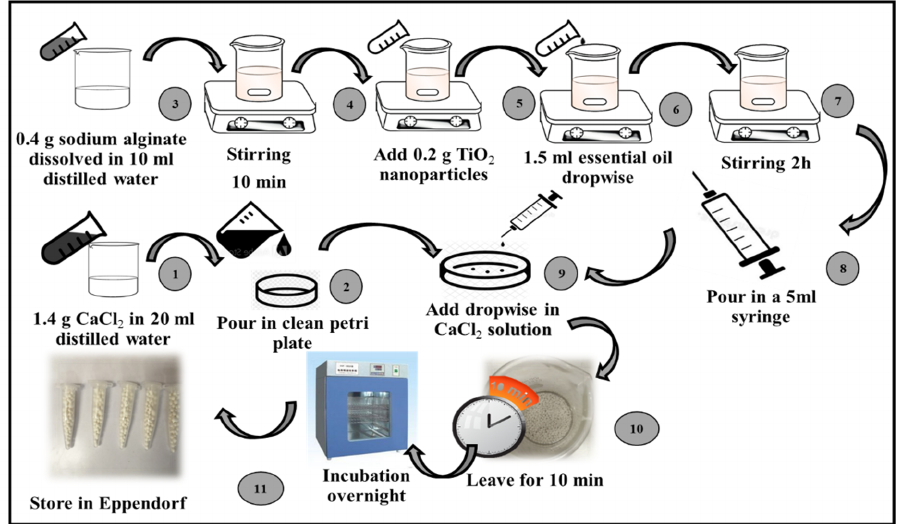
Figure 1. Biosynthesis of microspheres containing surface-modified essential oil-conjugated TiO 2 nanoparticles.